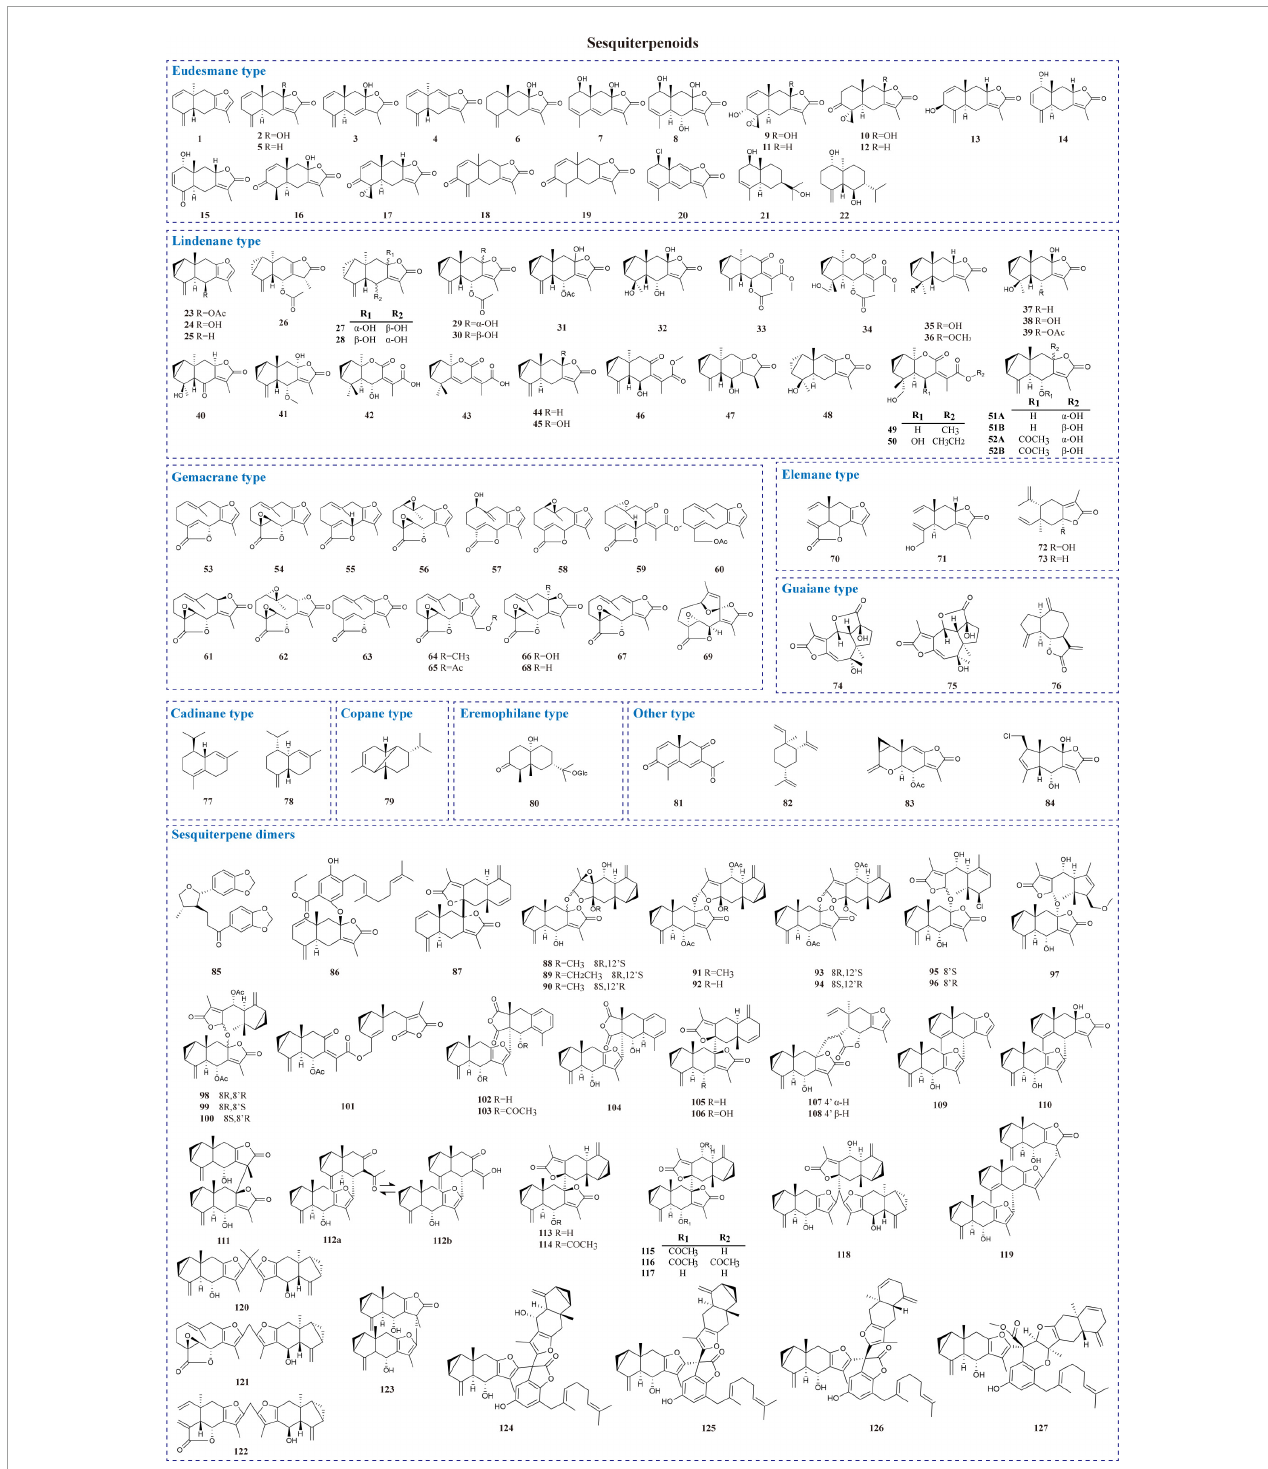
FIGURE2 Chemical structures of sesquiterpenoids in L.